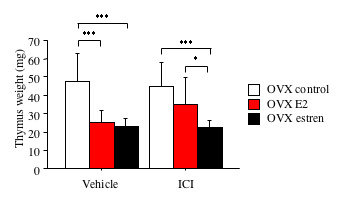
Estren reduces thymus weight independently of estrogen receptors. Ovariectomized 3-month-old female C57/B16 mice were treated for 18–21 days with daily s.c. injections of the estrogen receptor antagonist ICI 182,780 (200 μg/day) or vehicle Miglyol 812. Simultaneously, both the vehicle and the ICI groups were given daily s.c injections of either E2 (0.7 μg/day), estren (75 μg/day) or control Miglyol 812 oil. ICI 182,780 blocked the inhibitory effect of E2 on thymus weight. Treatment with estren resulted in lower thymus weight in both vehicle and ICI mice. One-way ANOVA followed by Fisher's test was used to compare data from mice in different treatment groups. Results are presented as mean ± standard deviation. * P < 0.05, *** P < 0.001.